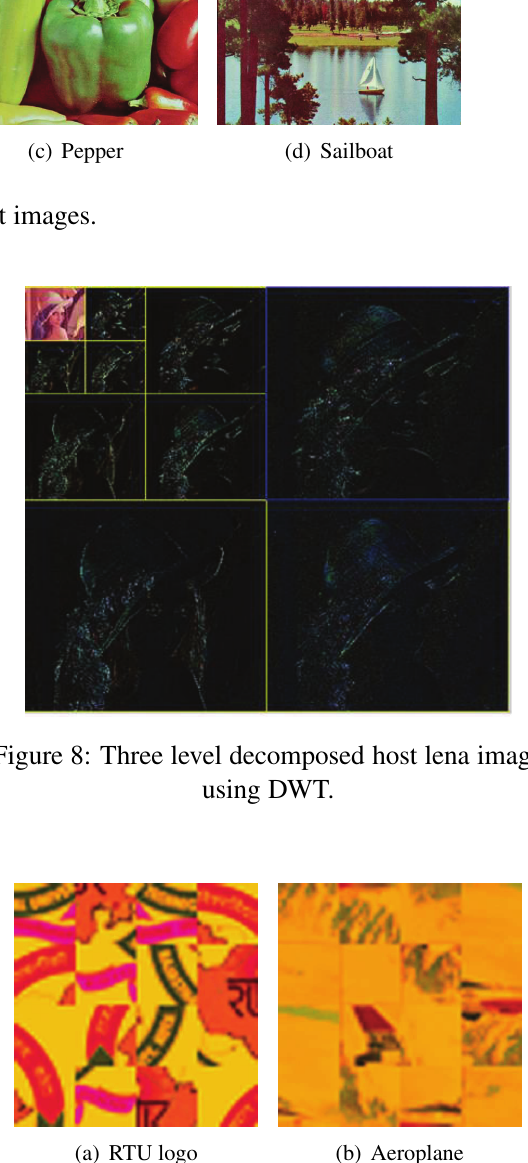
Figure 9: Representative scrambled UCS watermark